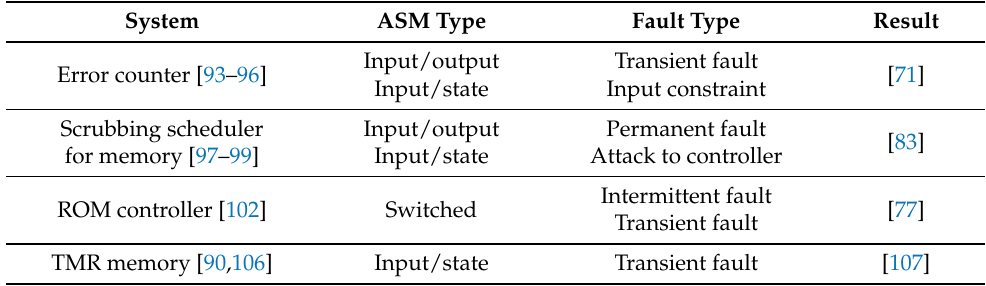
Table 1. Application study of fault-tolerant corrective control on space-borne digital